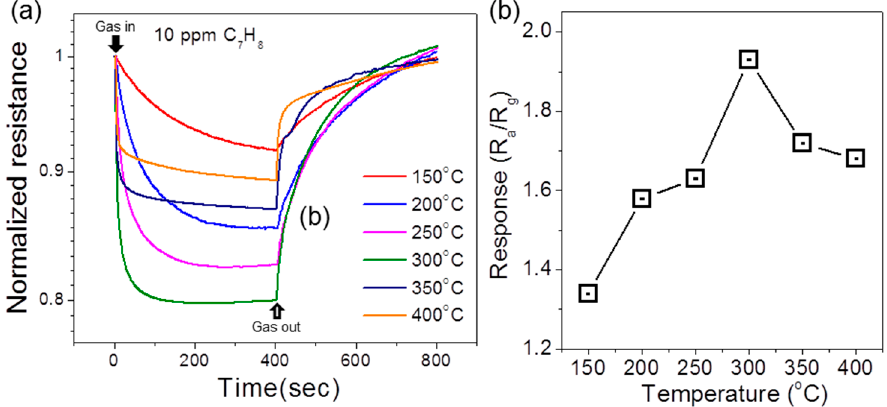
Figure 5. ( a ) Resistance curves of pure SnO 2 NFs exposed to 10 ppm C 7 H 8 at various temperatures; ( b ) Responses of pure SnO 2 as a function of operating temperature.